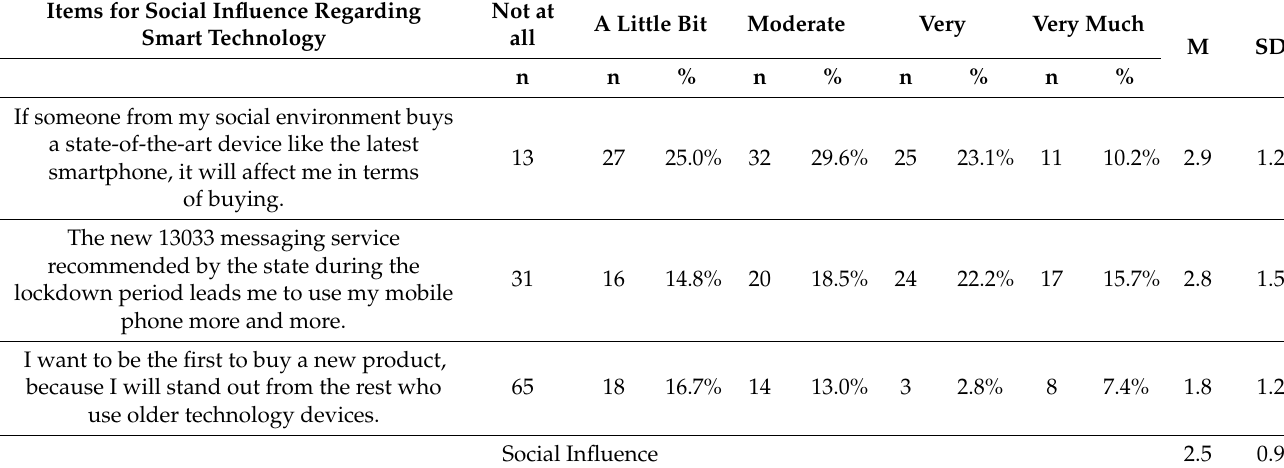
Table A5. Social influence regarding smart technology.